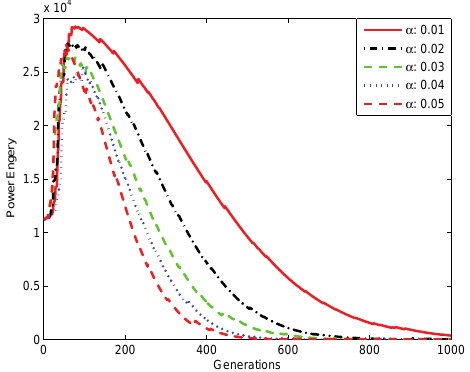
Figure 8: Di ff erent damping factors lead to di ff erent power energy in the evolutionary process